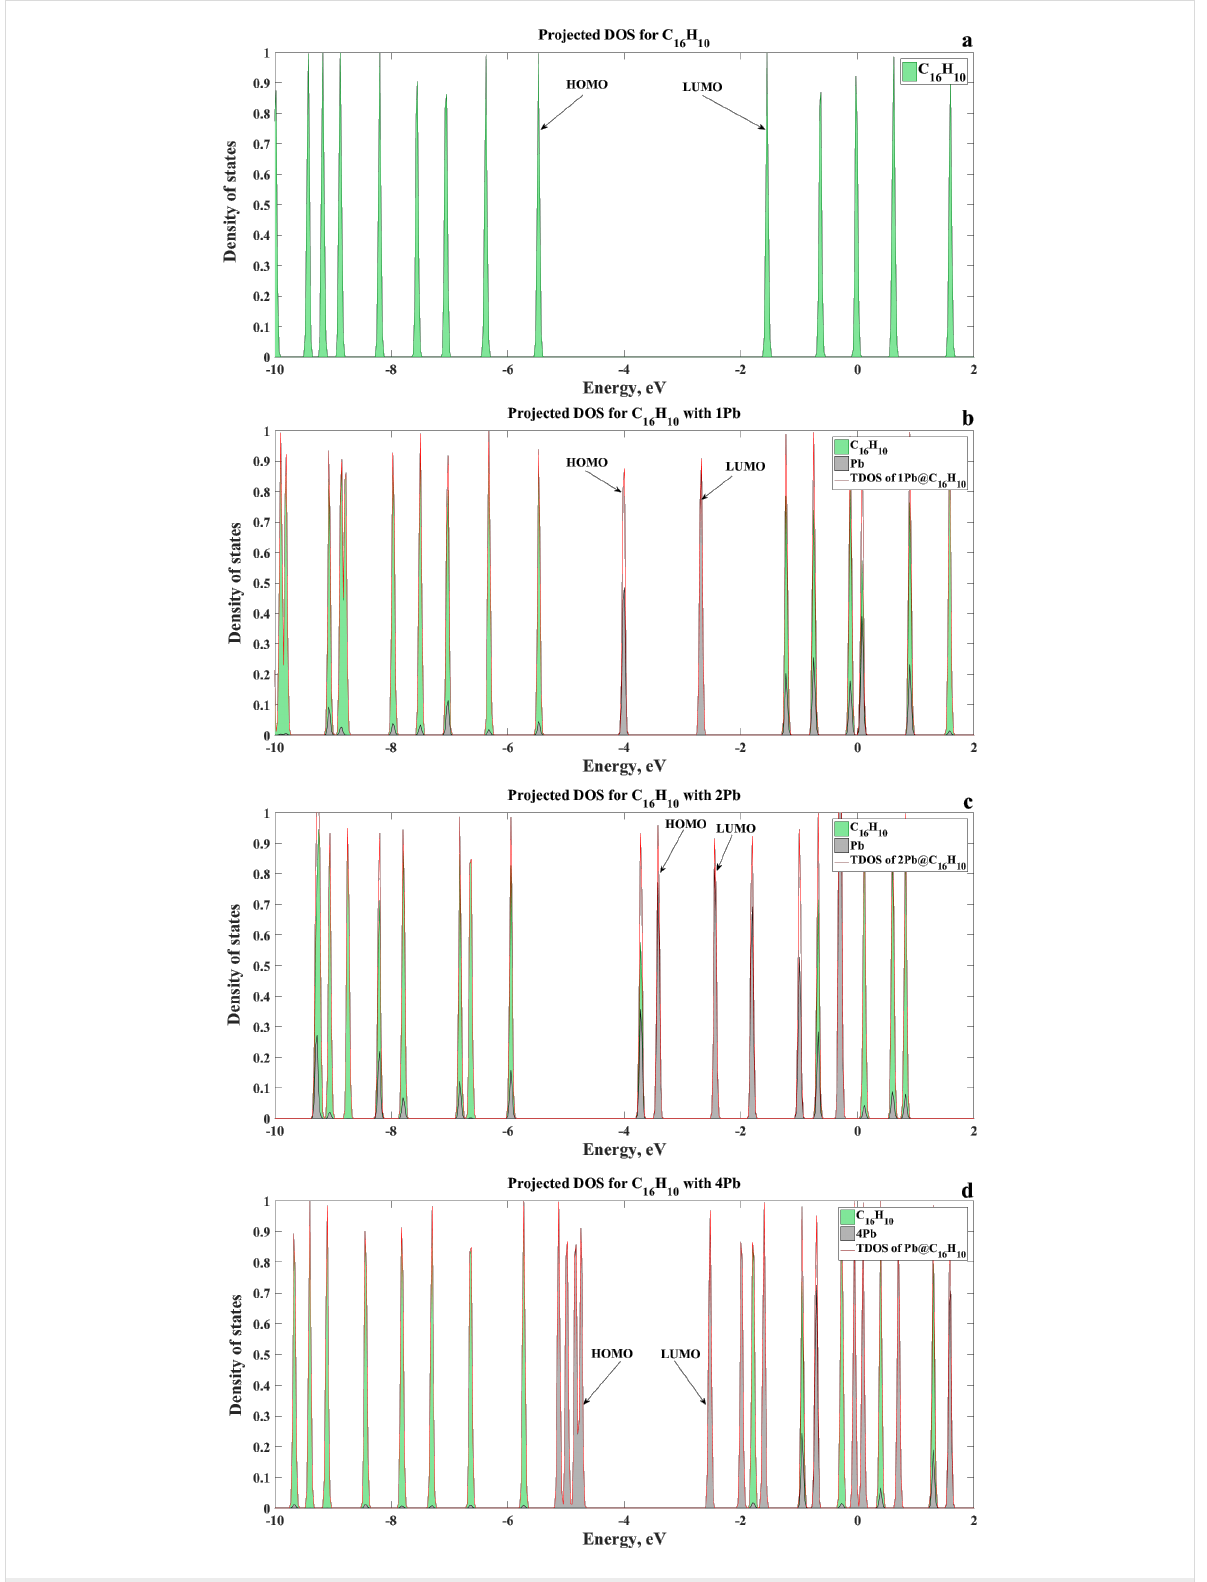
Figure 8: Total and projected DOS (PDOS) for graphene flakes atoms of the heavy metals: C 16 H 10 cluster without Pb (a) C 16 H 10 with 1 Pb (b), C 16 H 10 with 2 Pb (c) and C 16 H 10 with 4 Pb